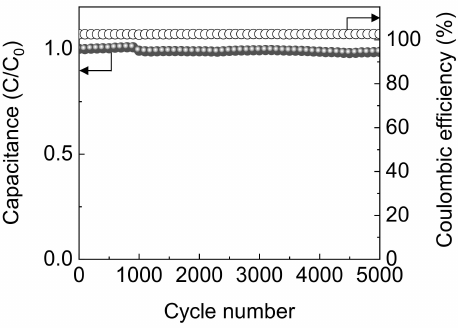
Figure 6. Long-term cycle stability and coulombic e ffi ciency of p-CNF over 5000 GCD cycles at 0.19 mA cm − 2 . C 0 is the initial capacitance and C is the capacitance at the indicated number of